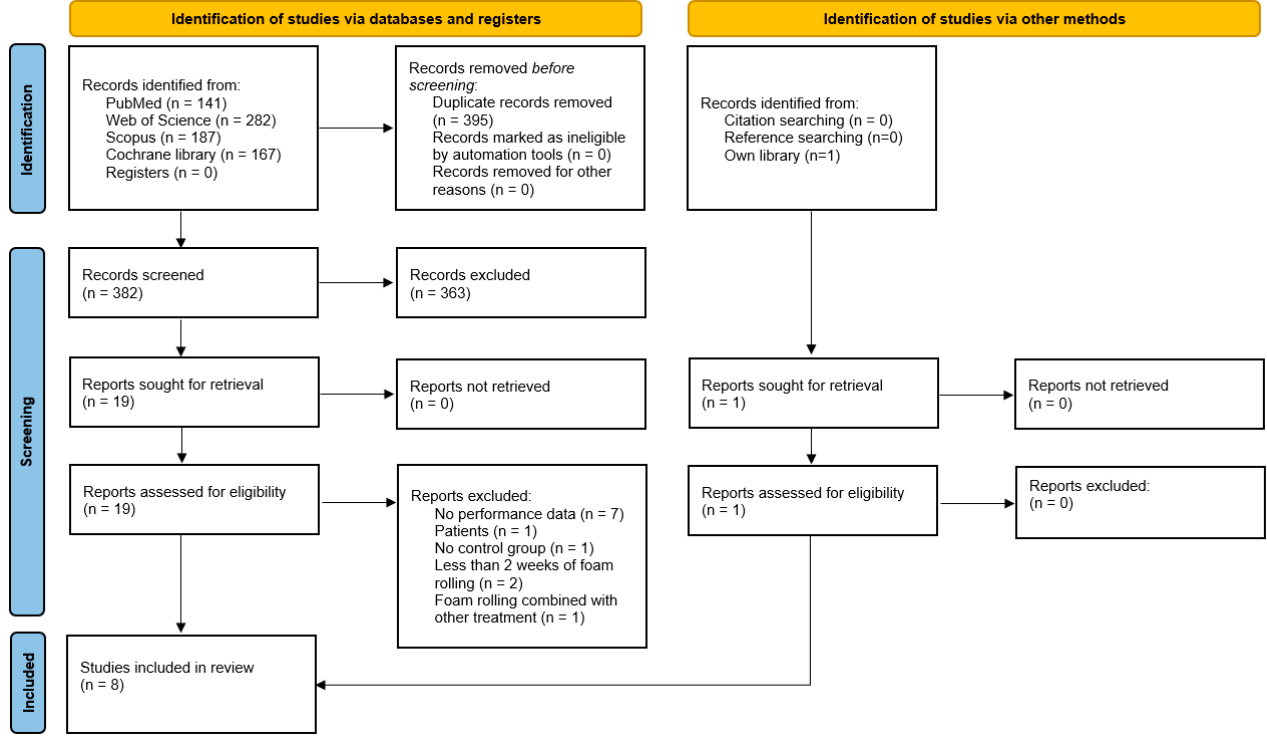
Figure 1. Prisma flowchart.